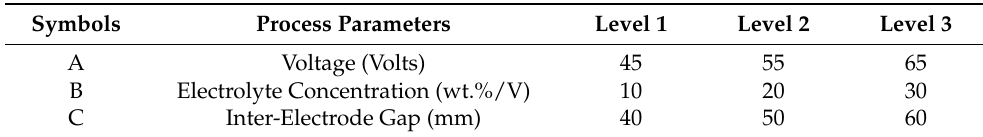
Table 1. Process parameters and their Levels.